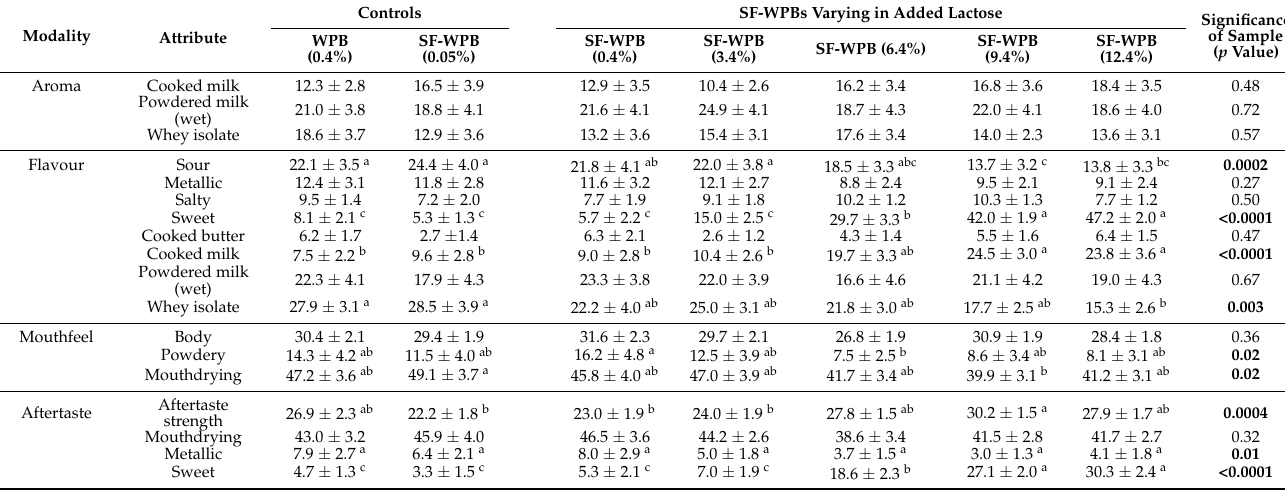
Table 5. Influence of lactose content on the sensory profile of whey protein liquid models (WPB: whey protein beverage; SF-WPB: sugar-free whey protein beverage).